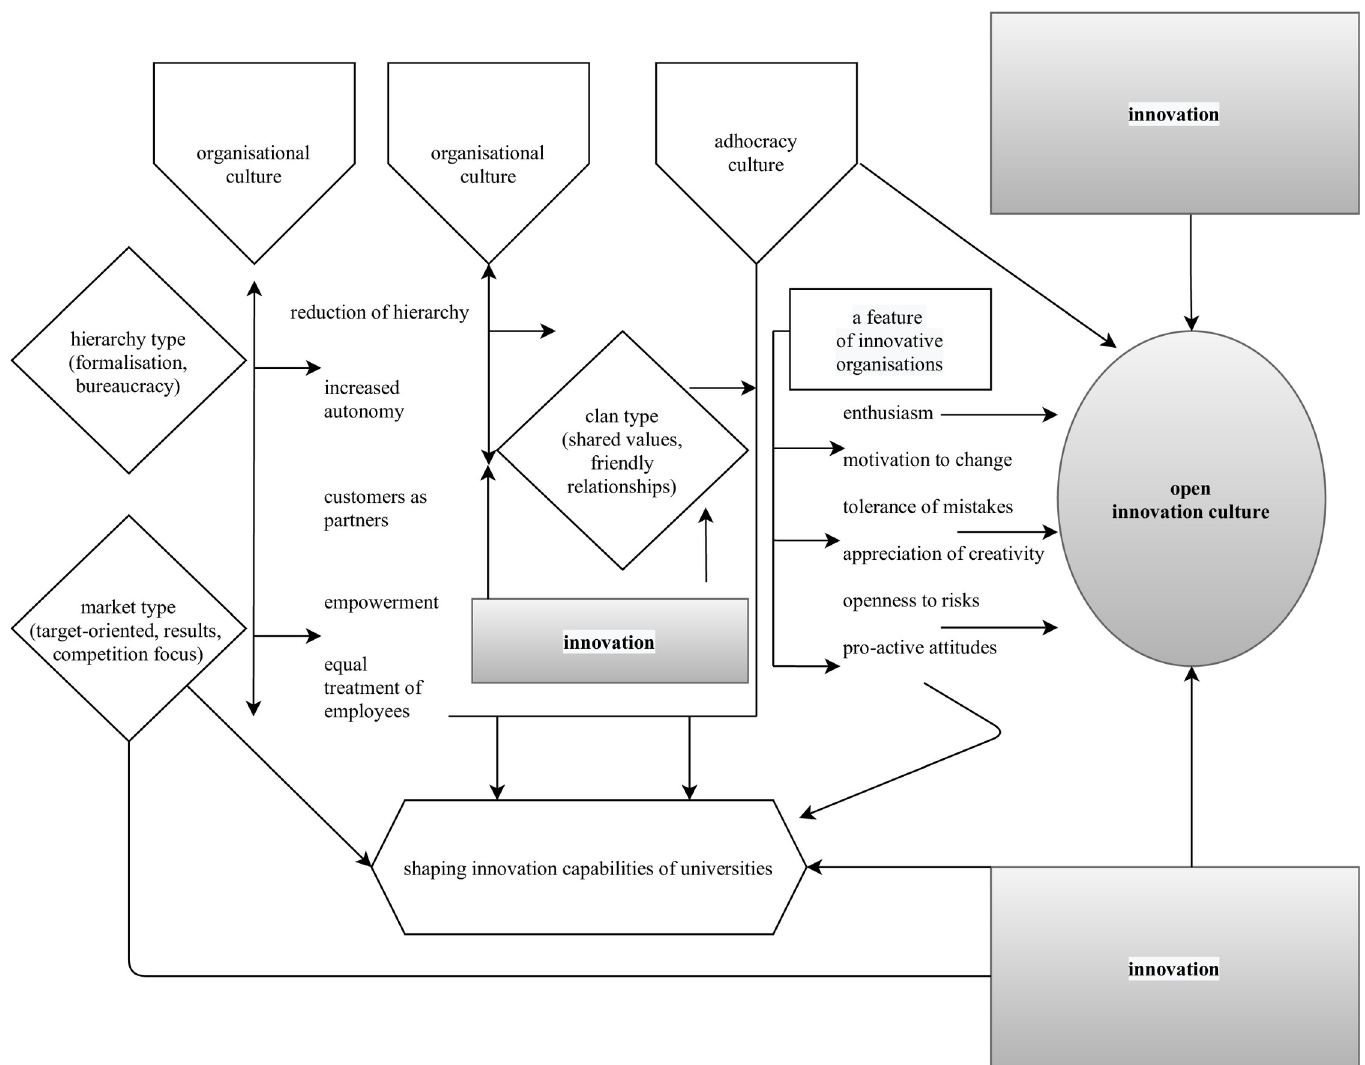
Fig 7. A model of how innovation-friendly organisational culture is formed at